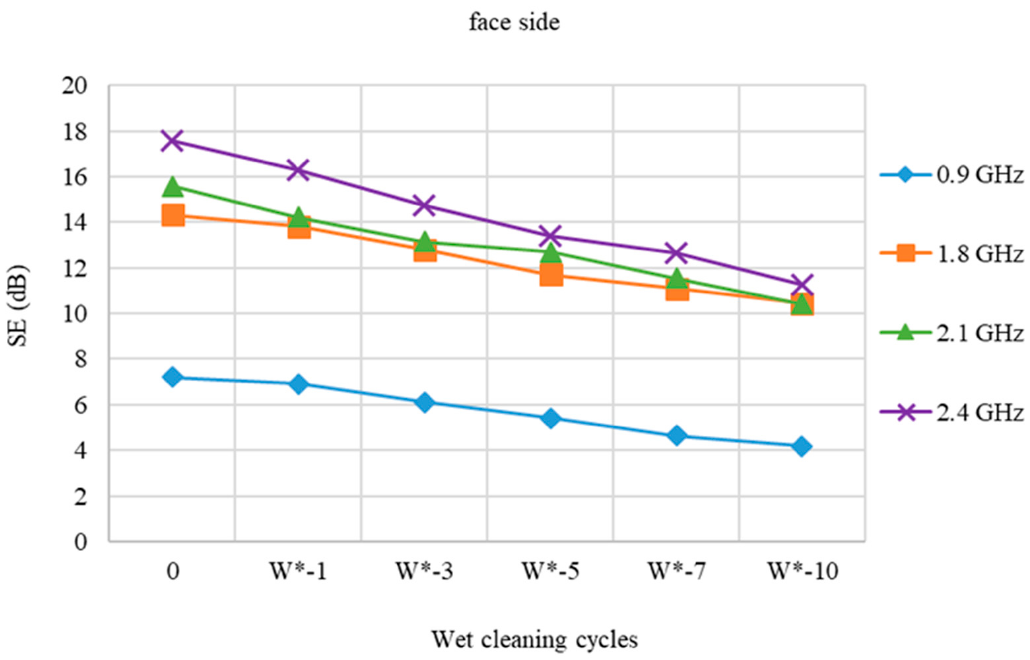
Figure 6. Shield effectiveness of PES/CO/SS fabric (face side) before and after 1st, 3rd, 5th, 7th, and 10th wet cleaning cycles (W*) at frequencies 0.9 GHz, 1.8 GHz, 2.1 GHz, and 2.4 GHz .